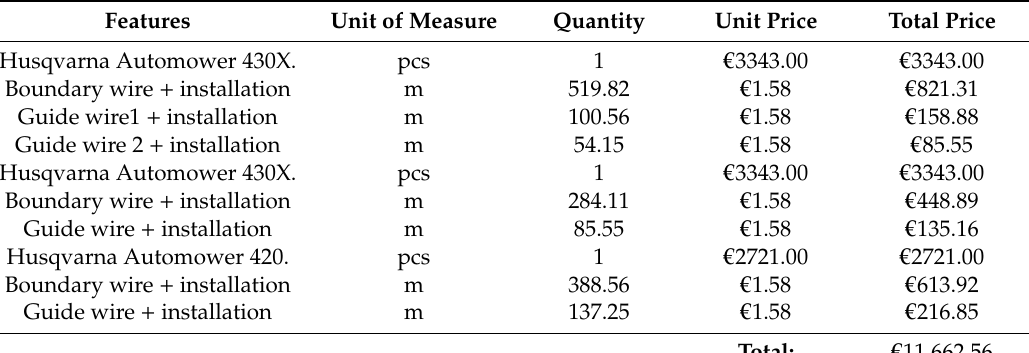
Table 3. Total costs of current management solution.